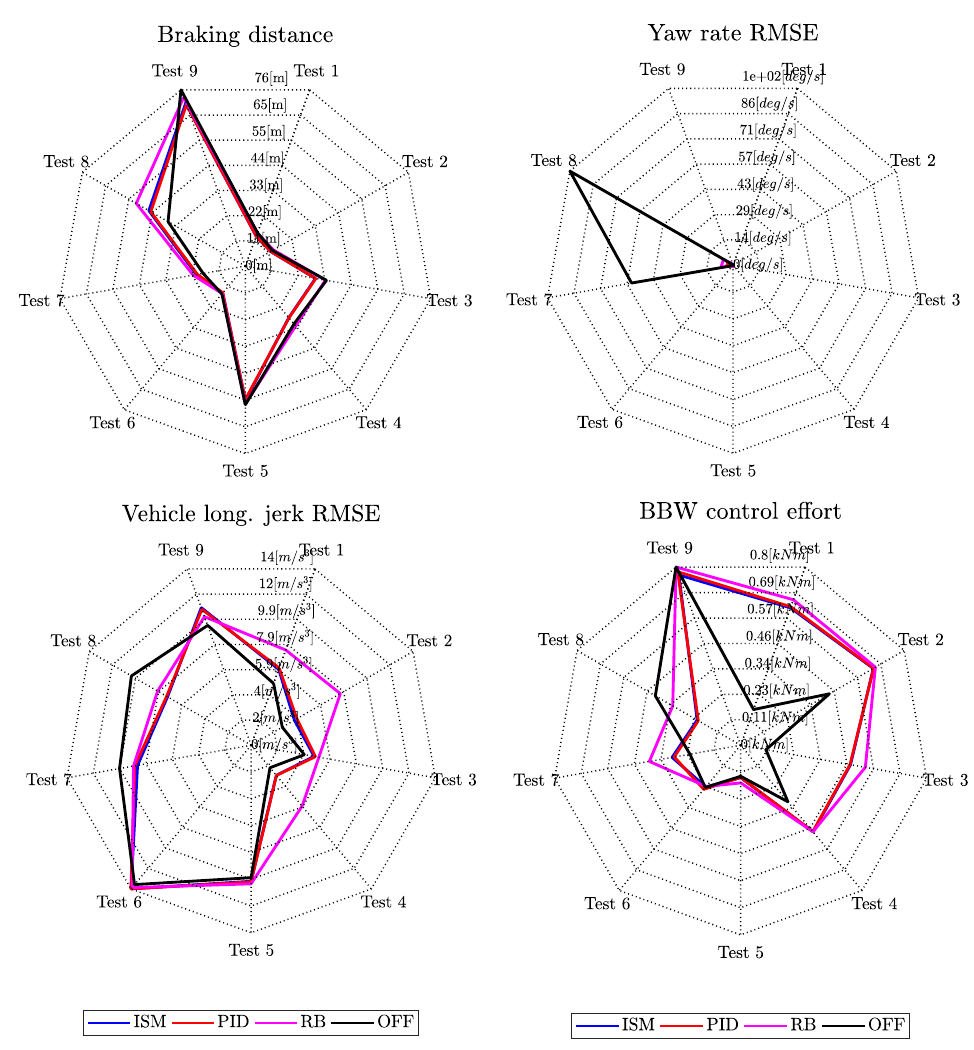
Figure 8. Radar plots of the identified KPIs; torque blending = inactive.